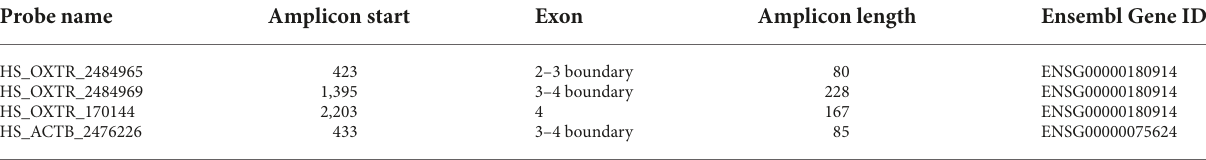
TABLE 1 Technical details of the QuantiNova LNA Probe PCR assays (Qiagen).